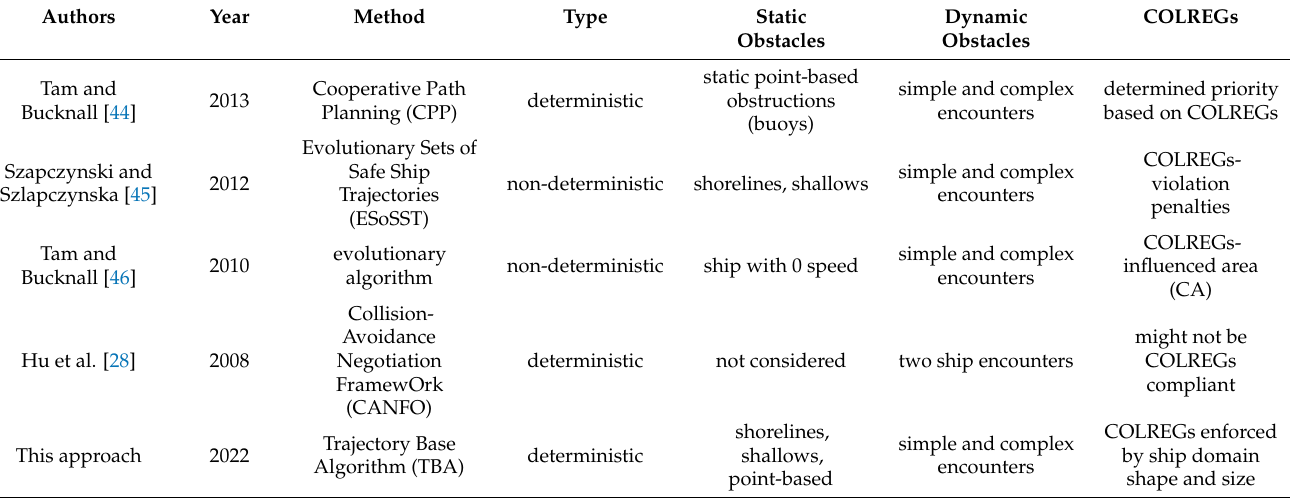
Table 14. Comparison of collision avoidance algorithms applicable in maneuver auto-negotiation systems—part 1.